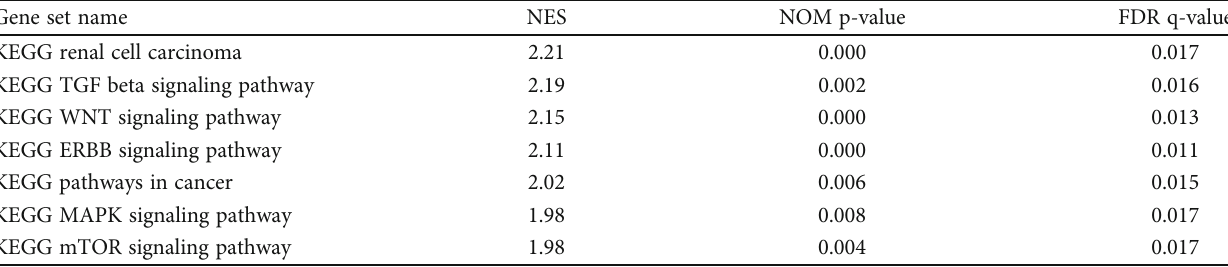
Figure 10: GSEA enrichment analysis. (a) The results of GO analysis in ccRCC with high-risk (red) and low-risk (blue) patients. (b) The seven most signi fi cantly enriched signaling pathways from KEGG. (c, d) Single-sample GSEA (ssGSEA) analysis showing the types of in fi ltrating immune cells (c) and the immune-related functions (d) in ccRCC with high risk (red) and low risk (blue). ∗ p < 0 : 05 , ∗∗ p < 0 : 01 , and ∗∗∗ p < 0 : 001 . ns: no signi fi Table 5: Gene set enrichment analysis result of the high-risk group.